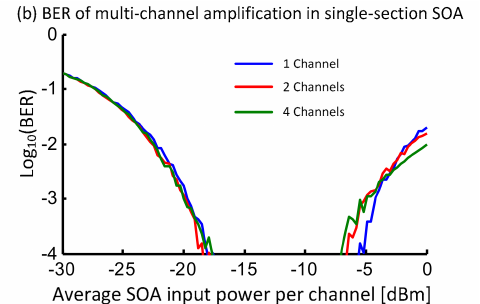
Figure 9. BER performance multi-channel PAM4 amplification performance in ( a ) multi-section SOA and ( b ) single-section SOA. Results are presented for one, two, and four co-propagating channels. At low input powers below − 15 dBm, the ASE of the SOAs dominates and the performance is independent of the number of channels. The multi-section SOA performs better due to the lower effective NF. At high input powers above − 10 dBm, there is a reduction in the useful dynamic range due to the increased crosstalk from the co-propagating